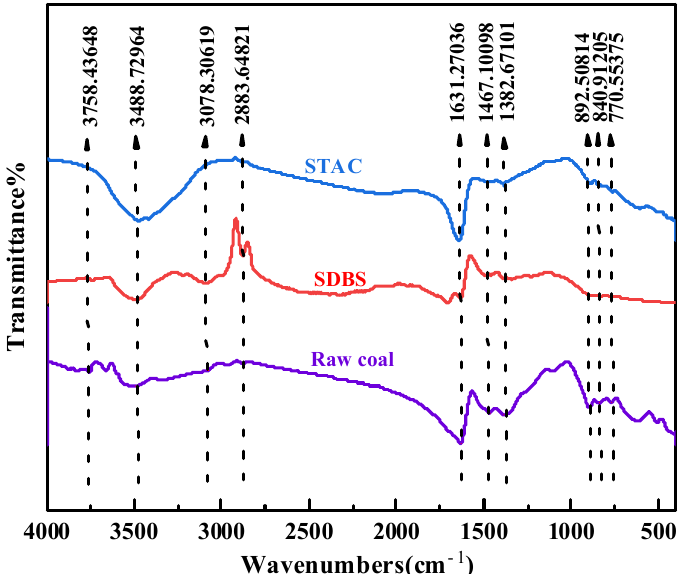
Figure 6. FTIR spectral map of anthracite adsorption of different surfactants.